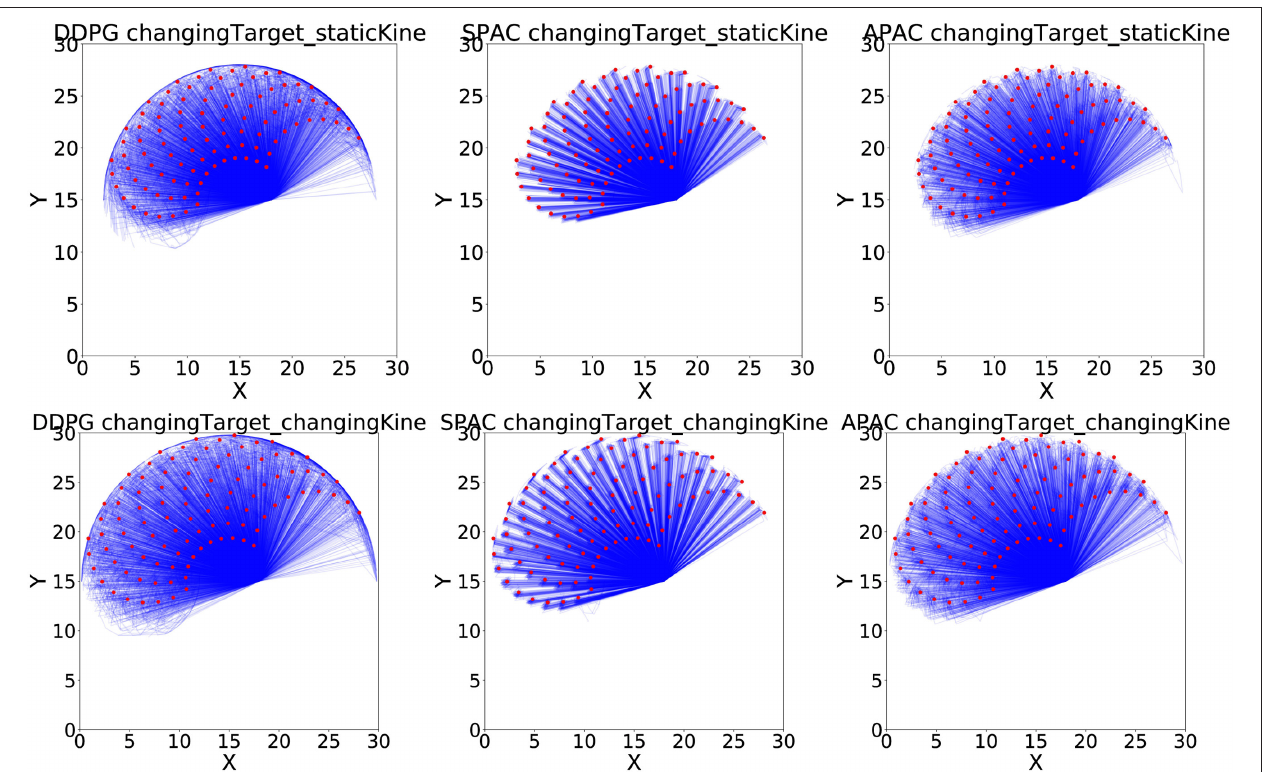
FIGURE 8 | Reaching examples of three models under changing target conditions. Blue lines show position of the end-effector at each time step toward the target, while red dots are target locations during the testing